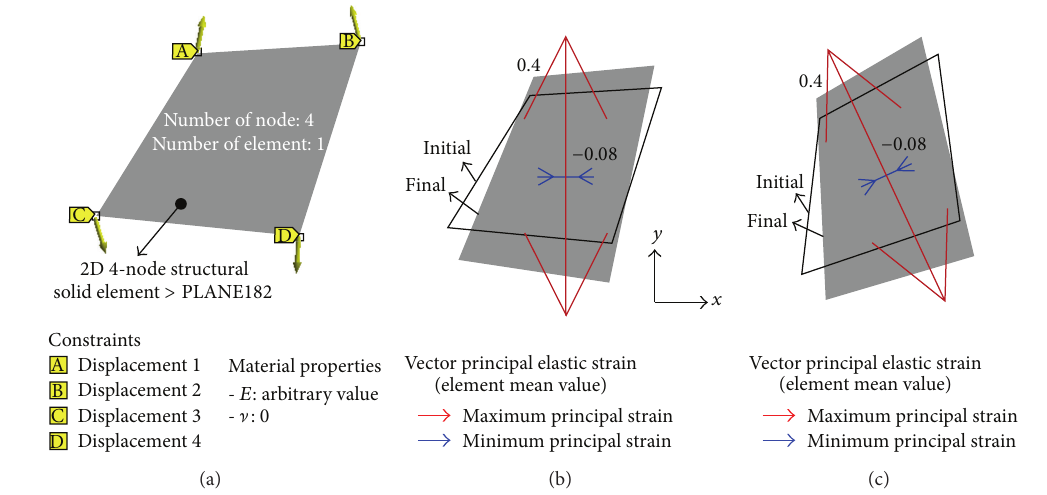
Figure 5: Finite element model and results: (a) FE model with applied conditions, (b) and (c) analysis results for the model in Figure 2 and the rotated model by 25 ∘ ,